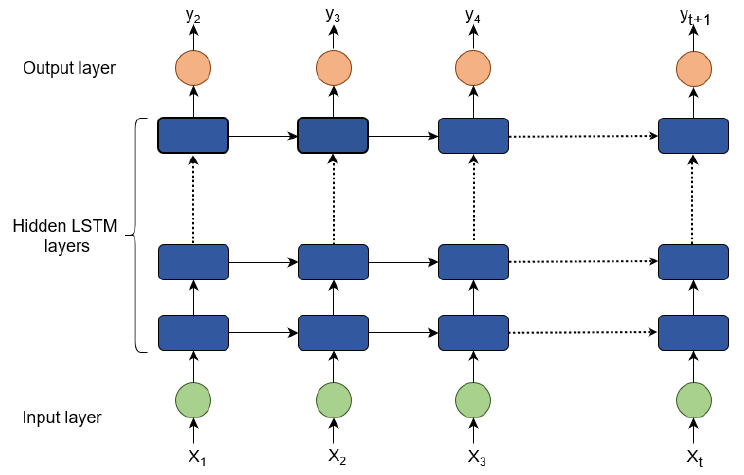
Figure 5. Deep LSTM architecture.